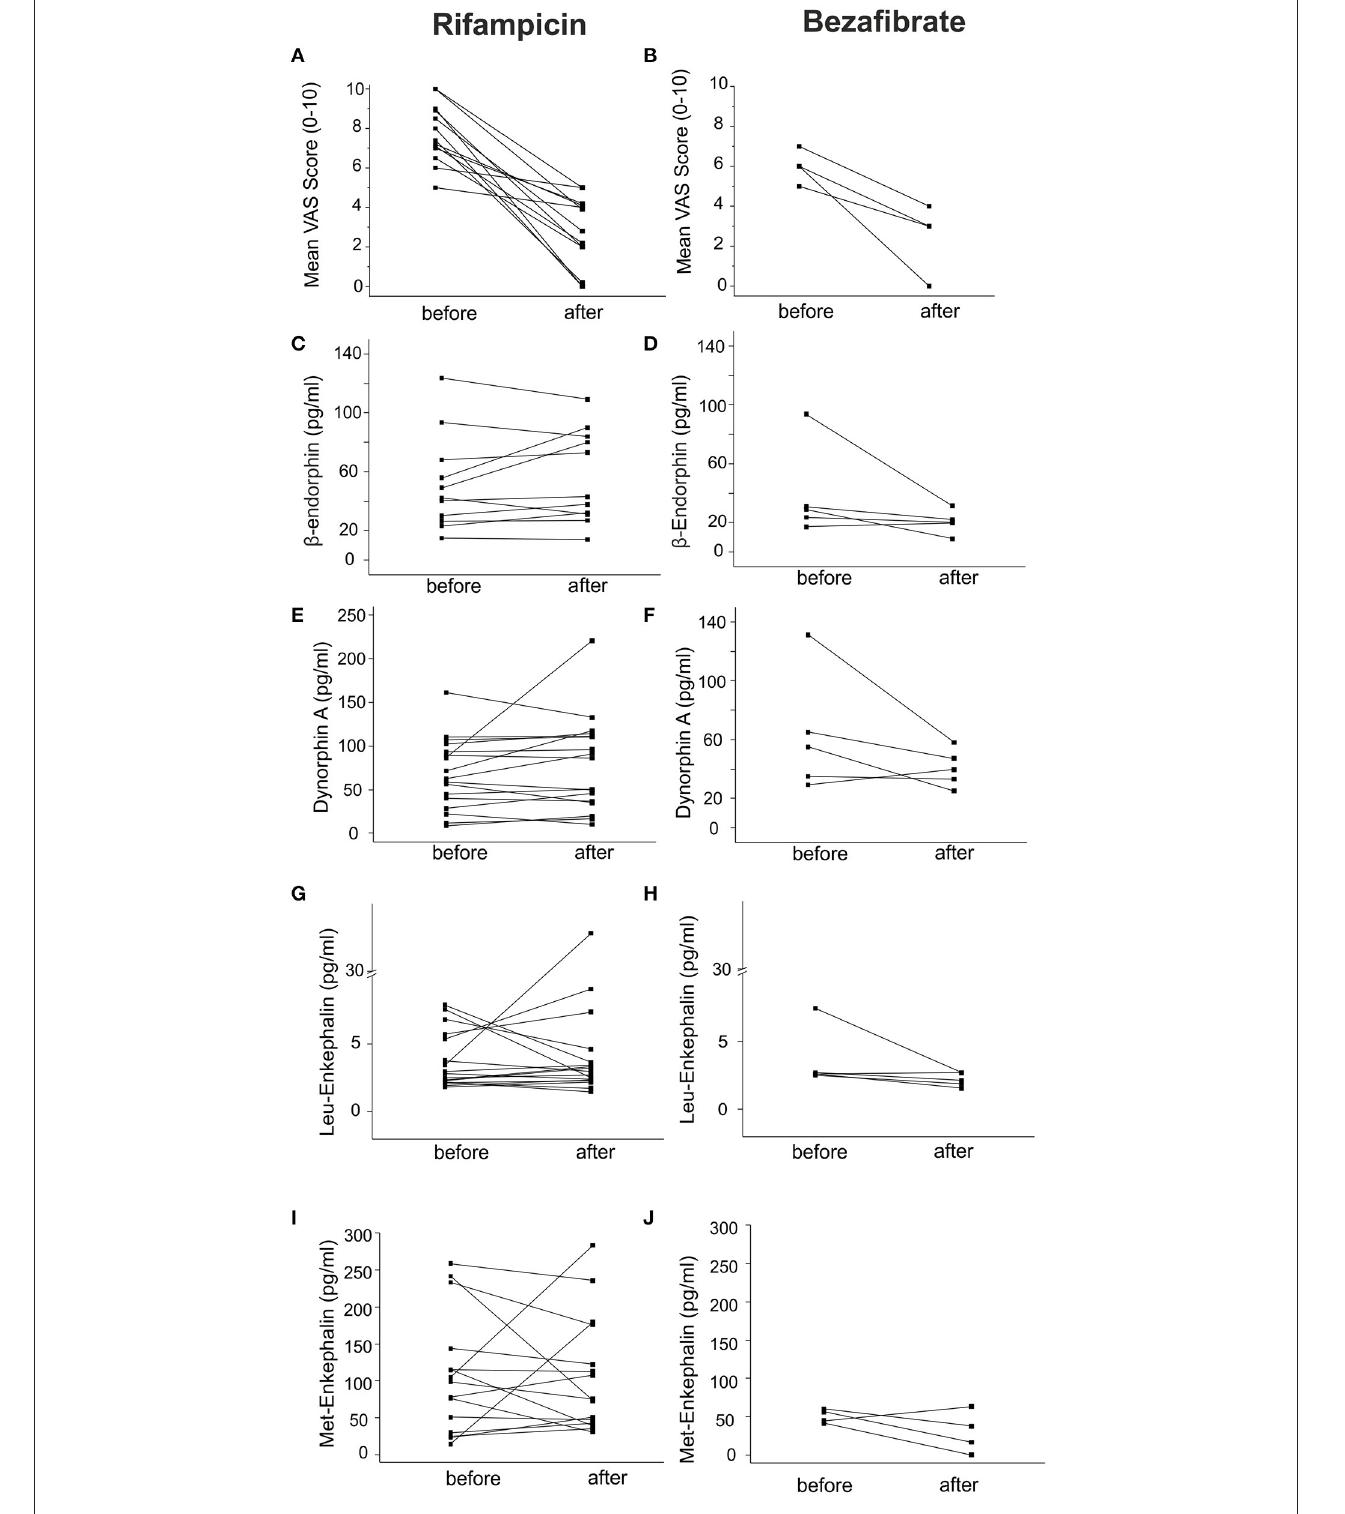
FIGURE 5 | Endogenous opioid plasma levels in patients with cholestatic liver diseases before and after anti-pruritic treatment. Endogenous opioid levels were assessed in 22 patients treated with the anti-pruritic drugs rifampicin (150–300mg qd) or bezafibrate (400mg qd). Black squares represent individual patient values before and after treatment. (A) and (B) indicate the mean change of VAS over the last week before and after treatment with the respective drugs. Levels of β -endorphin, dynorphin A, Leu- and Met-enkephalin did not significantly change during treatment with both drugs (C–J) . Data were statistically analyzed by Wilcoxon test.